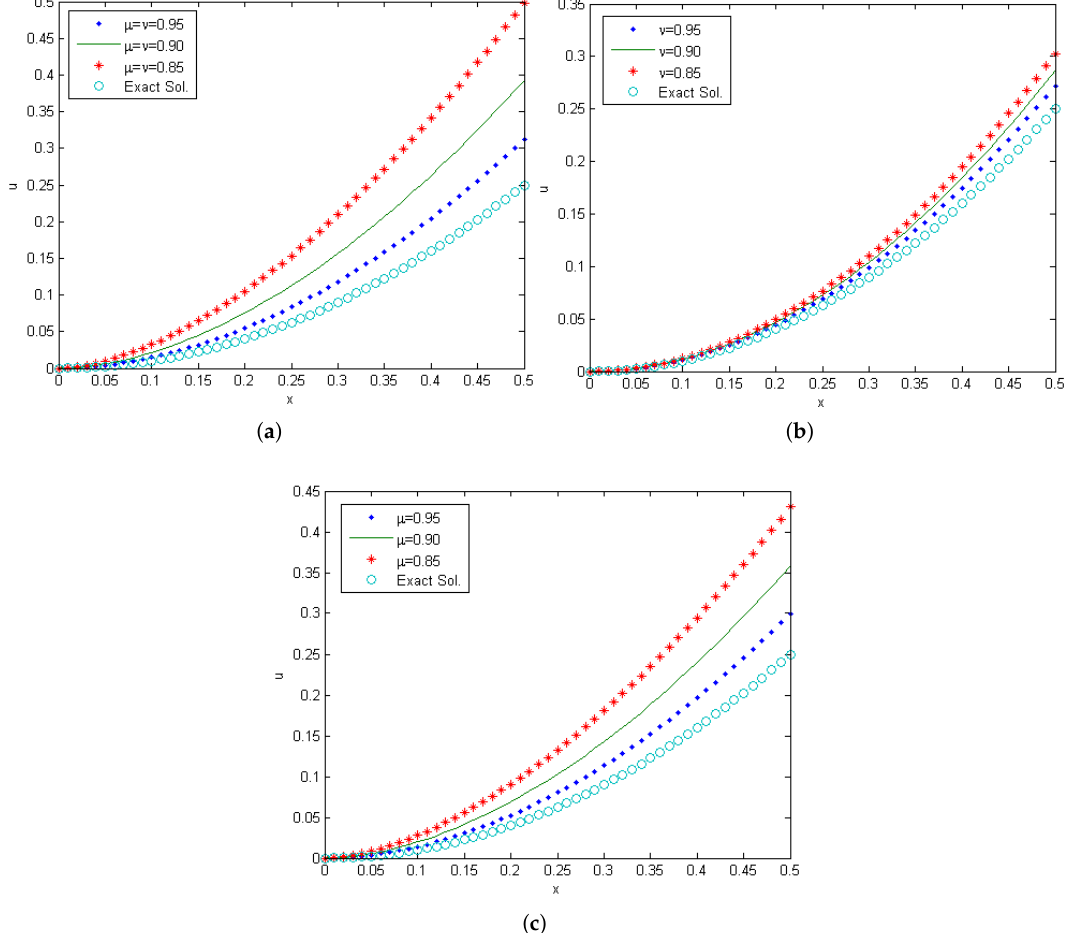
Figure 2. The solutions u ( x , t ) for Equation (20) for different values of µ and ν when t = π solutions u ( x , t ) for Equation (20) at µ = ν . ( b ) Plot solutions u ( x , t ) for Equation (20) when µ = 0.99 and different values of ν . ( c ) Plot solutions u ( x , t ) for Equation (20) for different values of µ at ν =